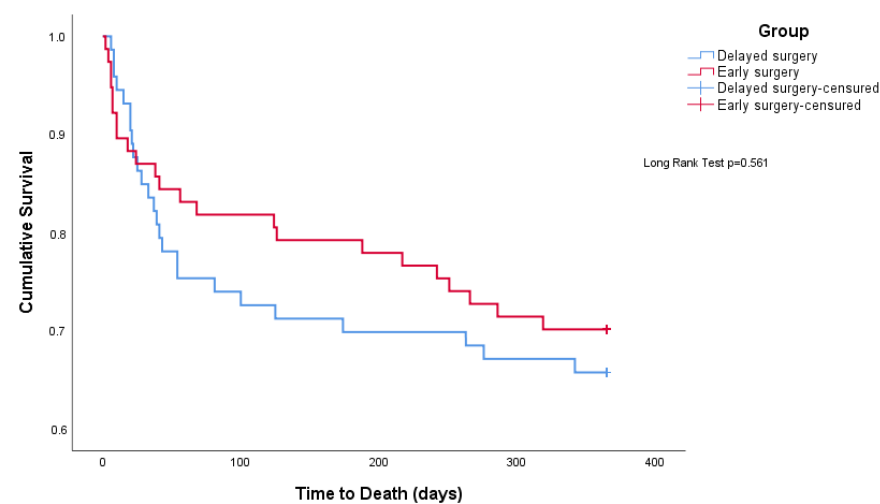
Figure 3. Patients’ survival by patients by group.